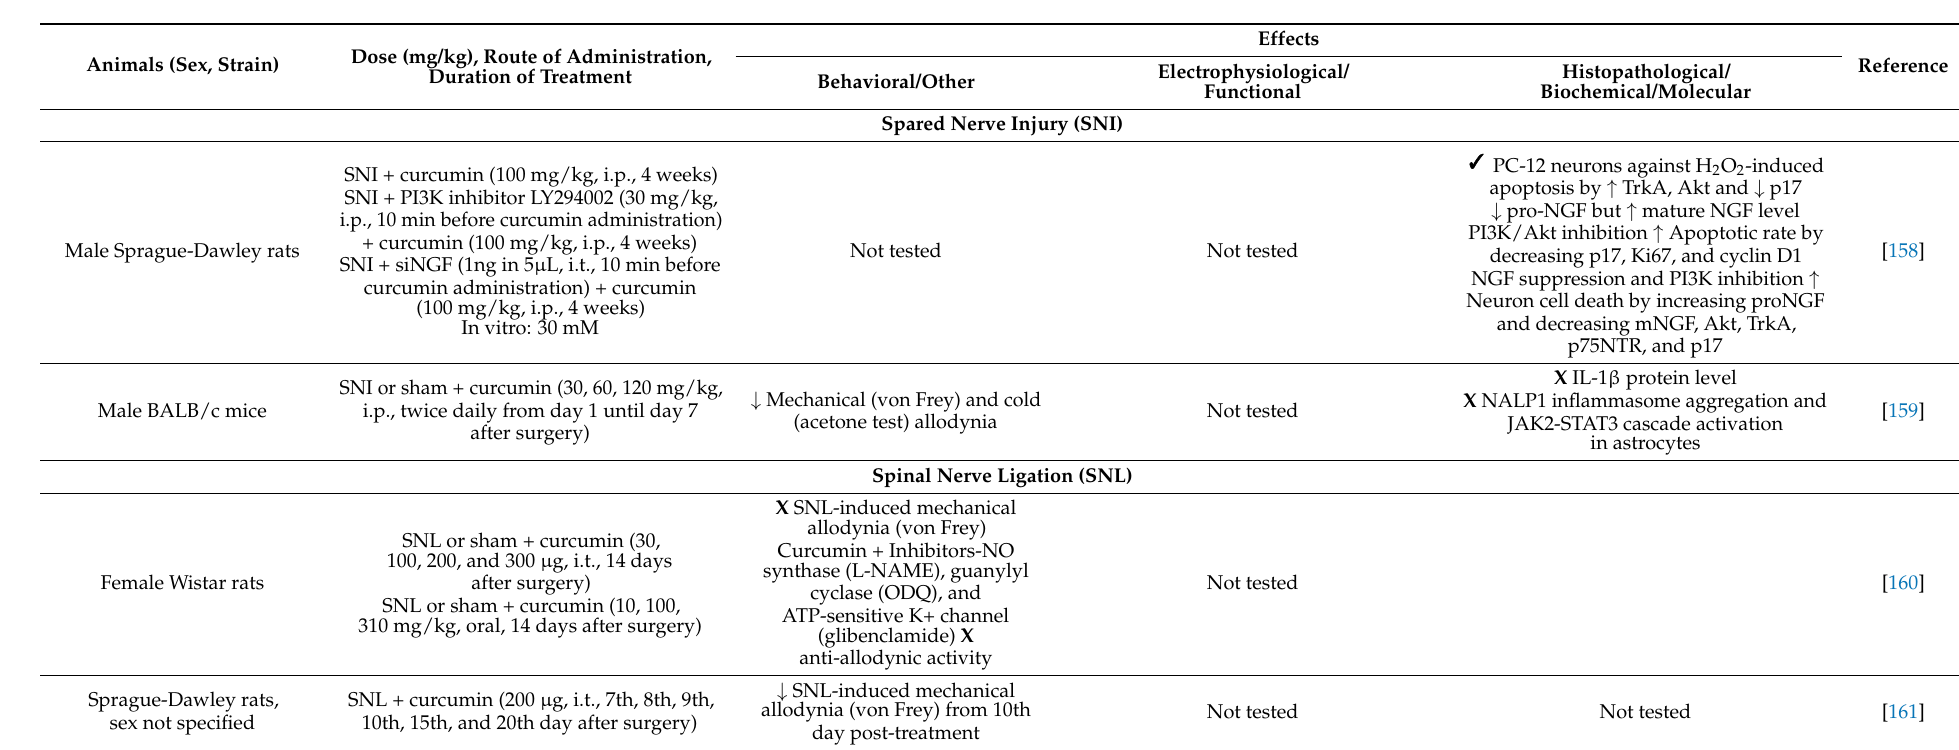
Table 2. Effects of curcumin on alcoholic neuropathy, chemotherapy-induced peripheral neuropathy (CIPN), and diabetic painful neuropathy (DPN). Animals (Sex,